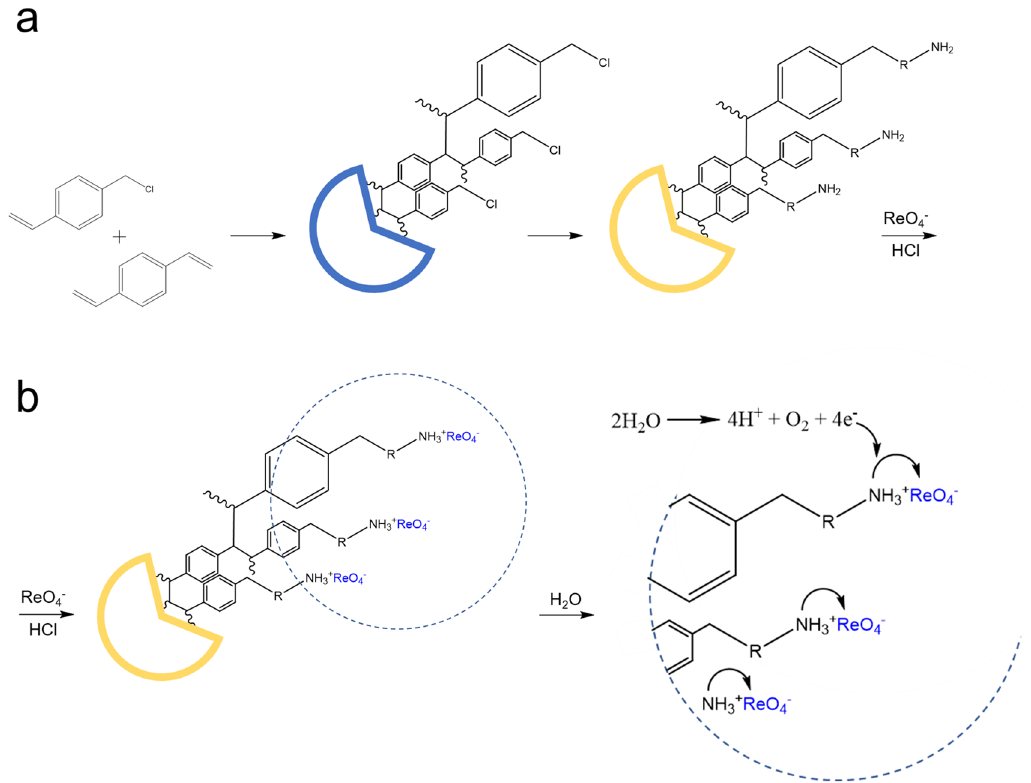
Figure 2. Synthesis of the pNCs with ReNSs. ( a ) Synthesis of the polymeric matrix, ( b ) Re(VII) loading and